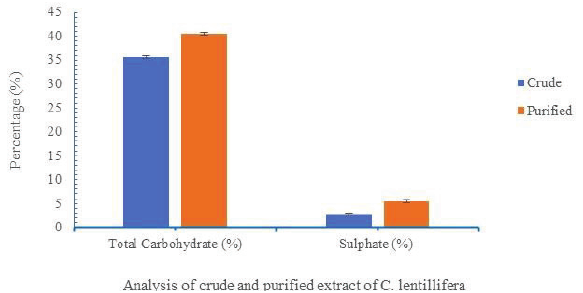
Figure 4. Analysis of total carbohydrate and sulfate of C. len- tillifera . 1 H-NMR